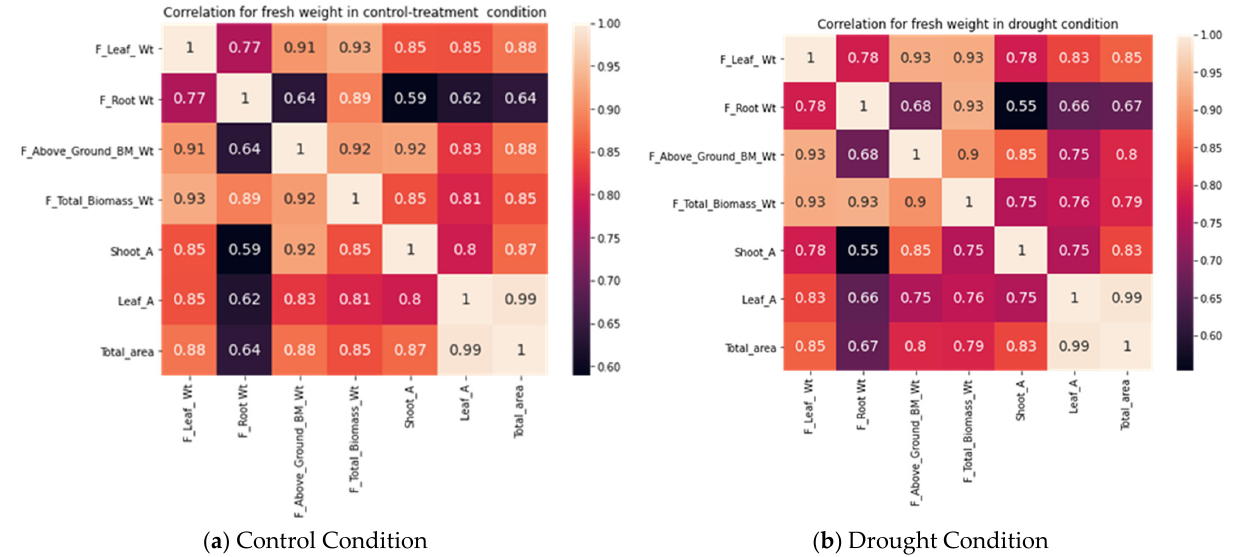
Figure 10. Correlation among different quantitative traits in ( a ) control or well-watered condition and ( b ) drought treatment for rice plant. Table 1. Descriptive statistics of the quantitative traits and image traits of different genotypes for plants in control treatment.